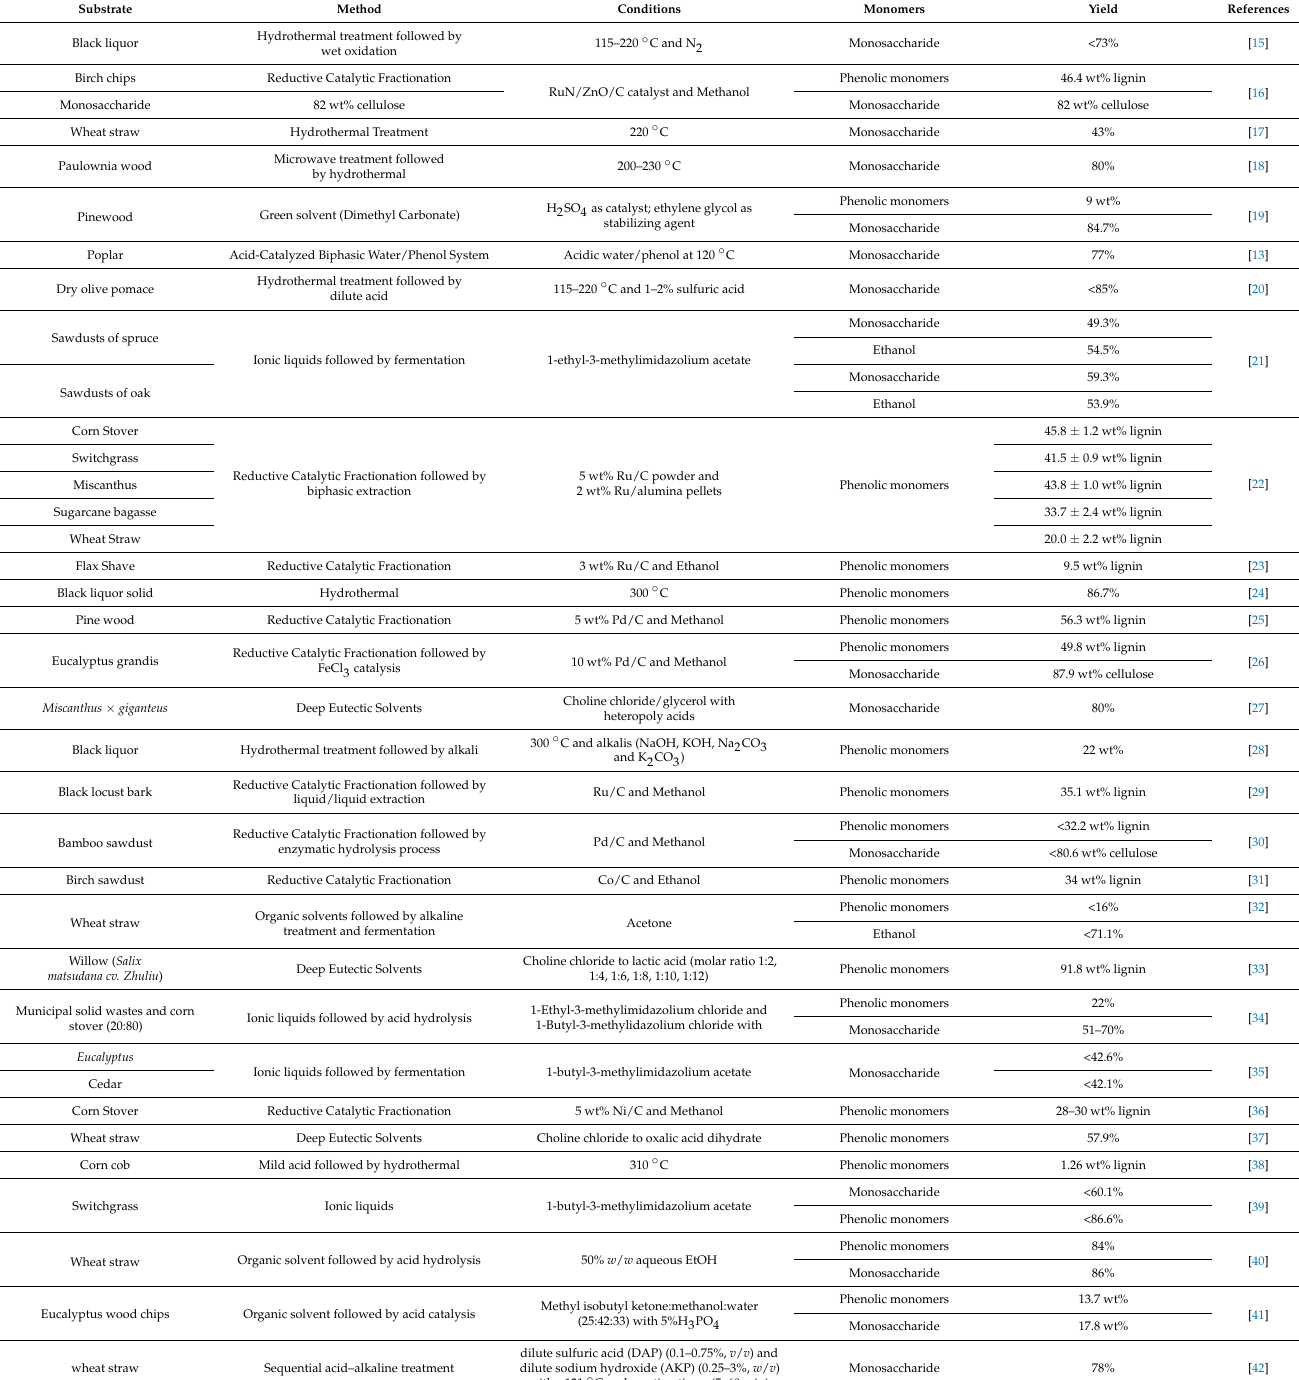
Table 1. Fractionation of lignocellulosic biomass to monosaccharides and phenolic